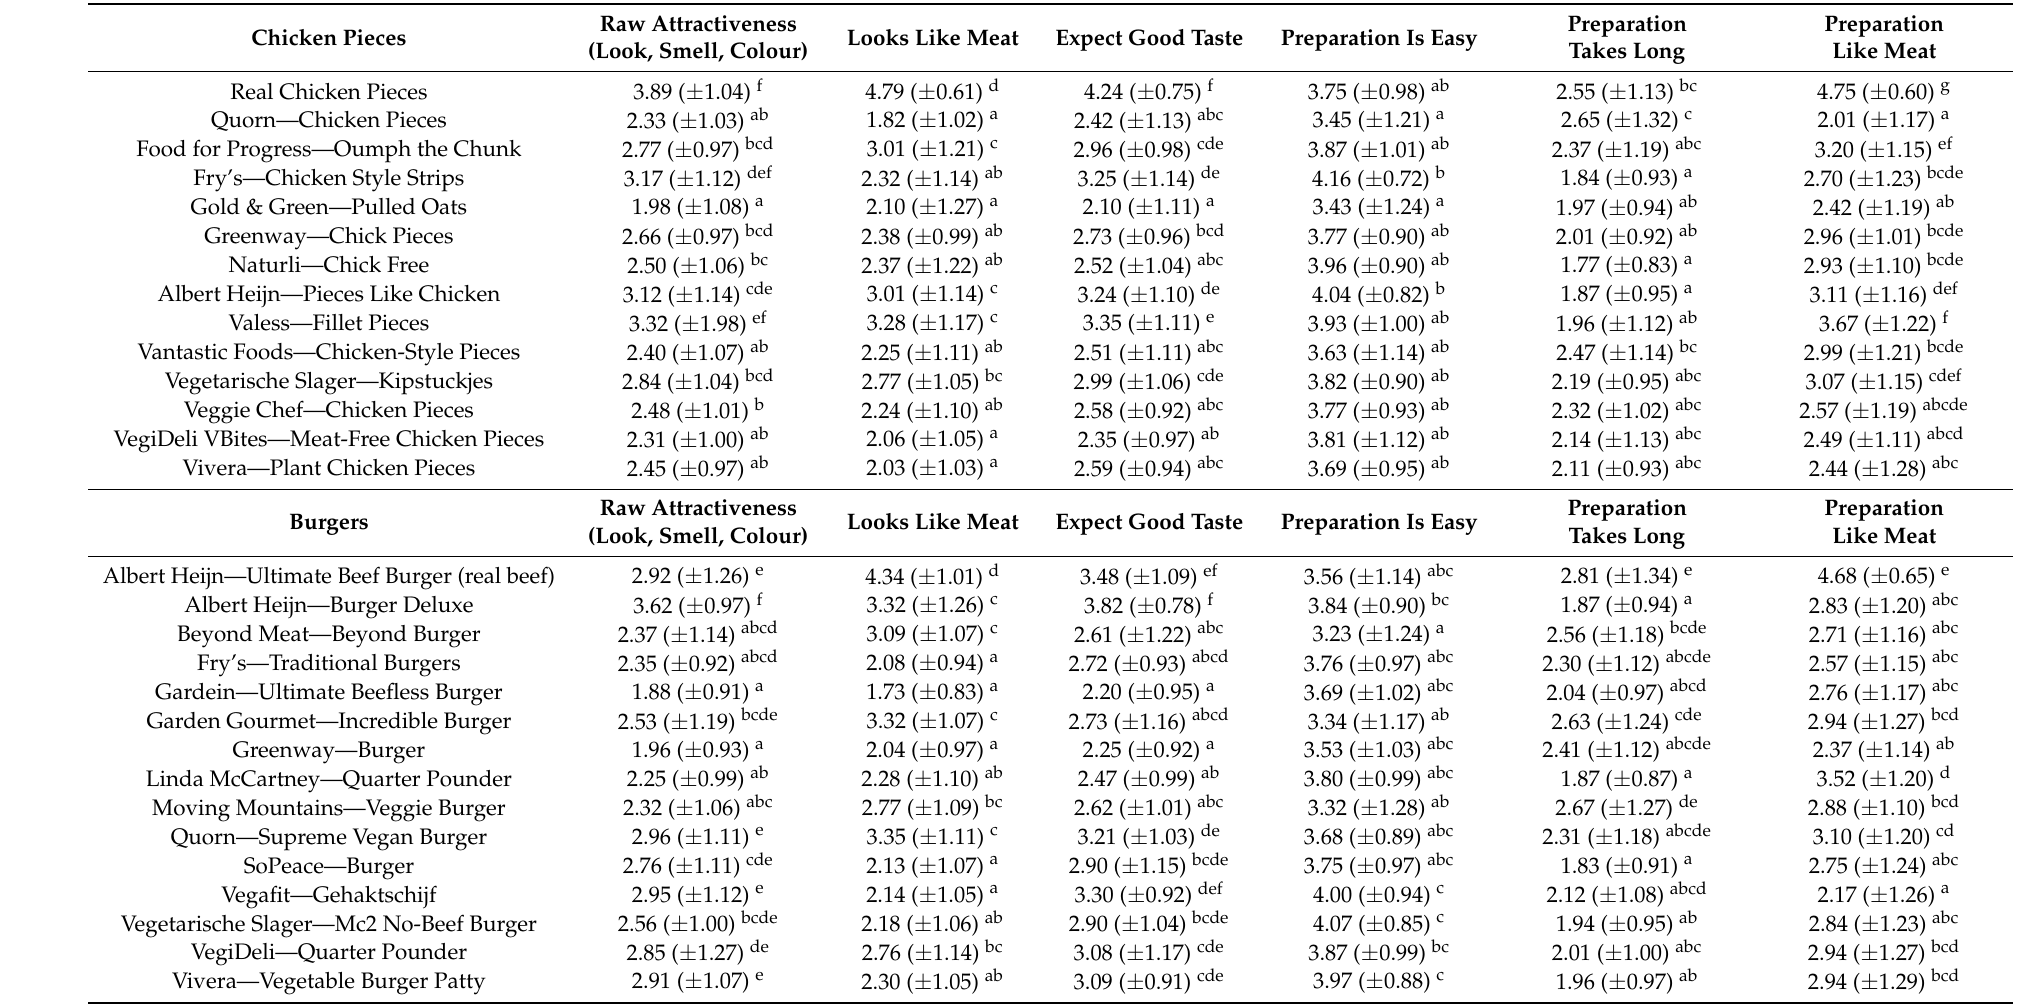
Table 4. Raw appeal and preparation scores (scales 1–5) for the meat analogues studied in the present research ( n = 71). Different letters refer to statistical differences for the different parameters in the